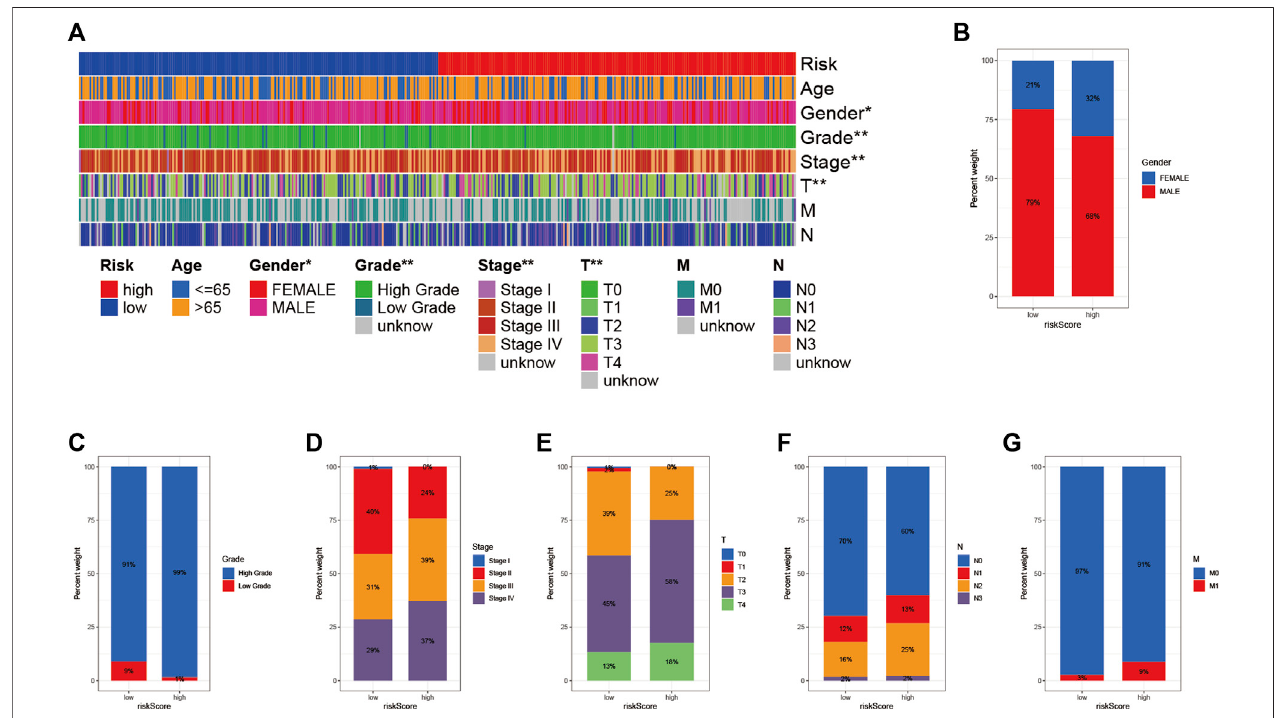
FIGURE 6 | Clinical signi fi cance of prognostic risk characteristics (A) heatmap showing the distribution of clinical characteristics and corresponding risk scores in each sample. Incidence of clinical variable subtypes of LRG/HRG (B) Gender (C) Grade (D) Stage (E) Stage T (F) Stage N, and (G) Stage M.